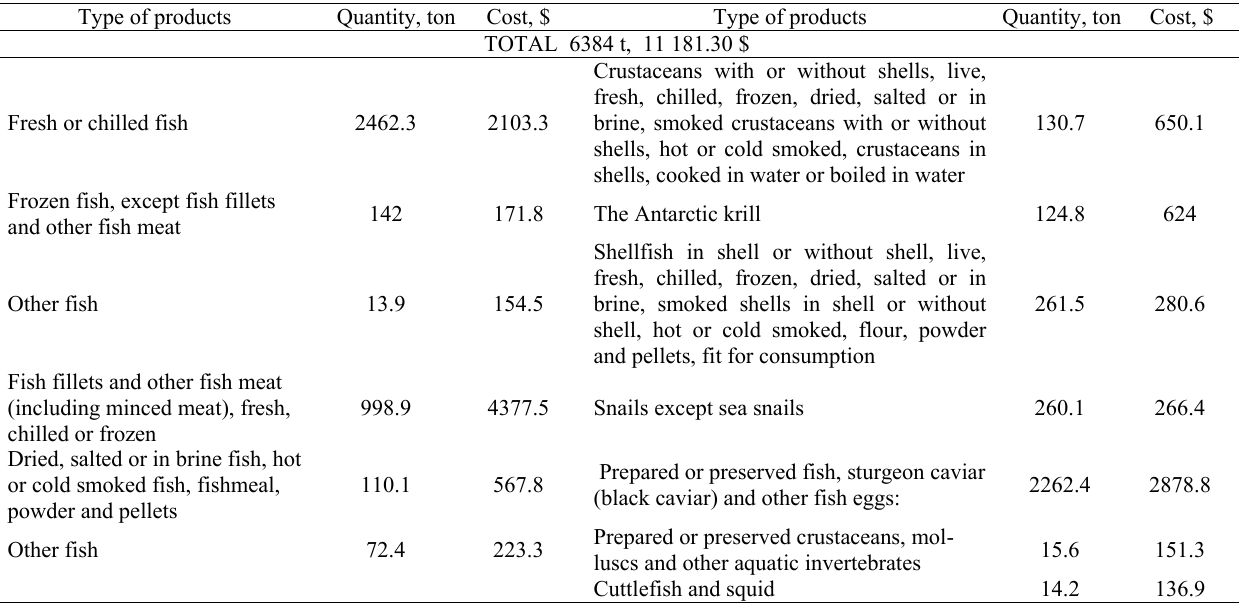
Fig. 1. The export of fish products of Ukraine 2015–2019 (according to the State Statistics Committee of Ukraine) The export of fish, fish products and other aquatic bio- resources in January-August 2015 decreased by 80 % com- pared to the same period of 2014, which is primarily due to the lease of the vessels from which fishing was directed for export, and the ban on the import of canned fish to Russia. The export of fish and fish products of Ukraine in January-August 2015 (according to the State Statistics Committee of